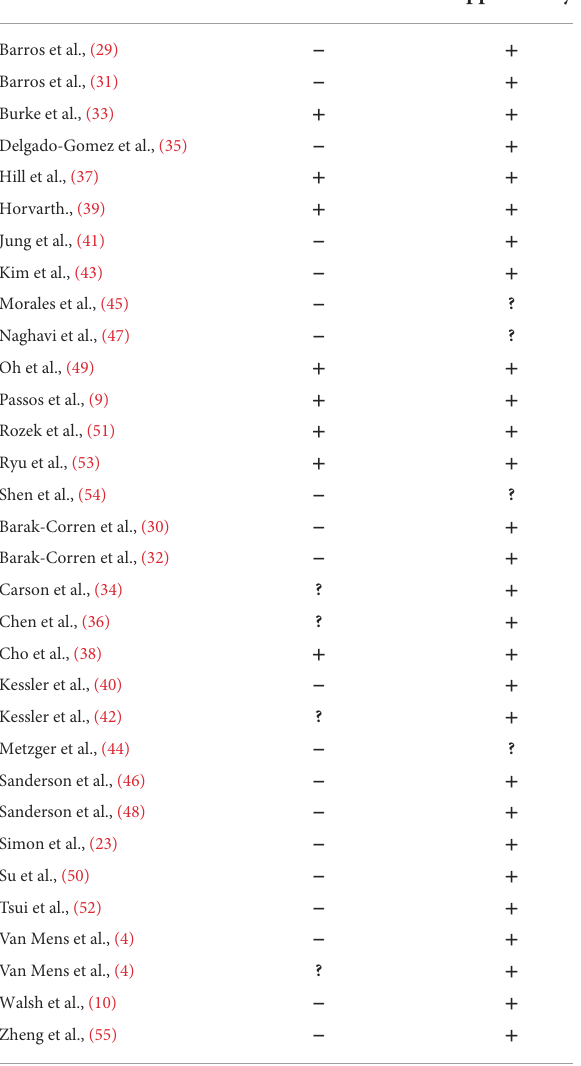
TABLE 4 PROBAST risk of bias